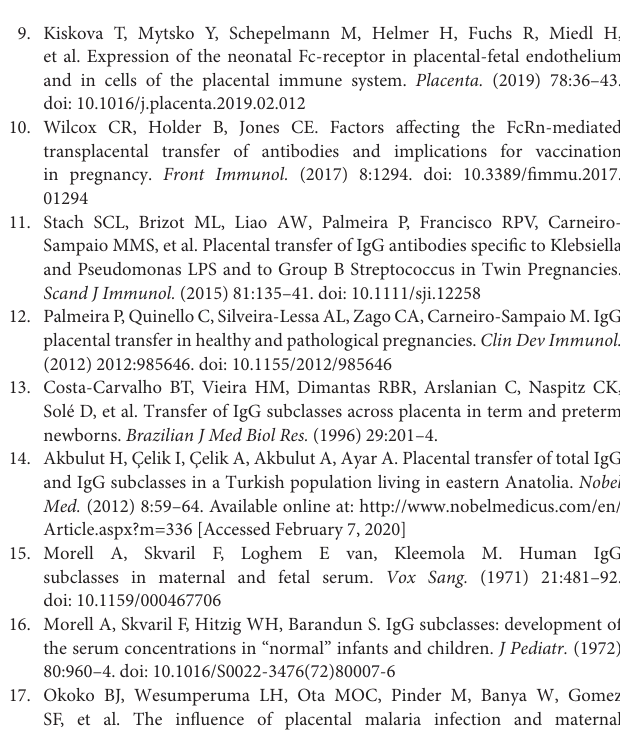
Supplemental Table 1 | Descriptive statistics of maternal to fetal transfer of total IgG and IgG